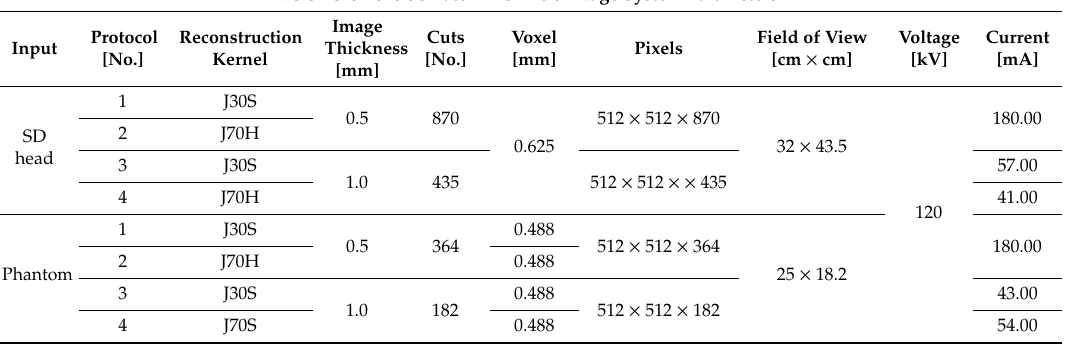
Table 1. Parameters of multi-slice computed tomography (MSCT) imaging for the sus domesticus (SD) head and the Phantom.